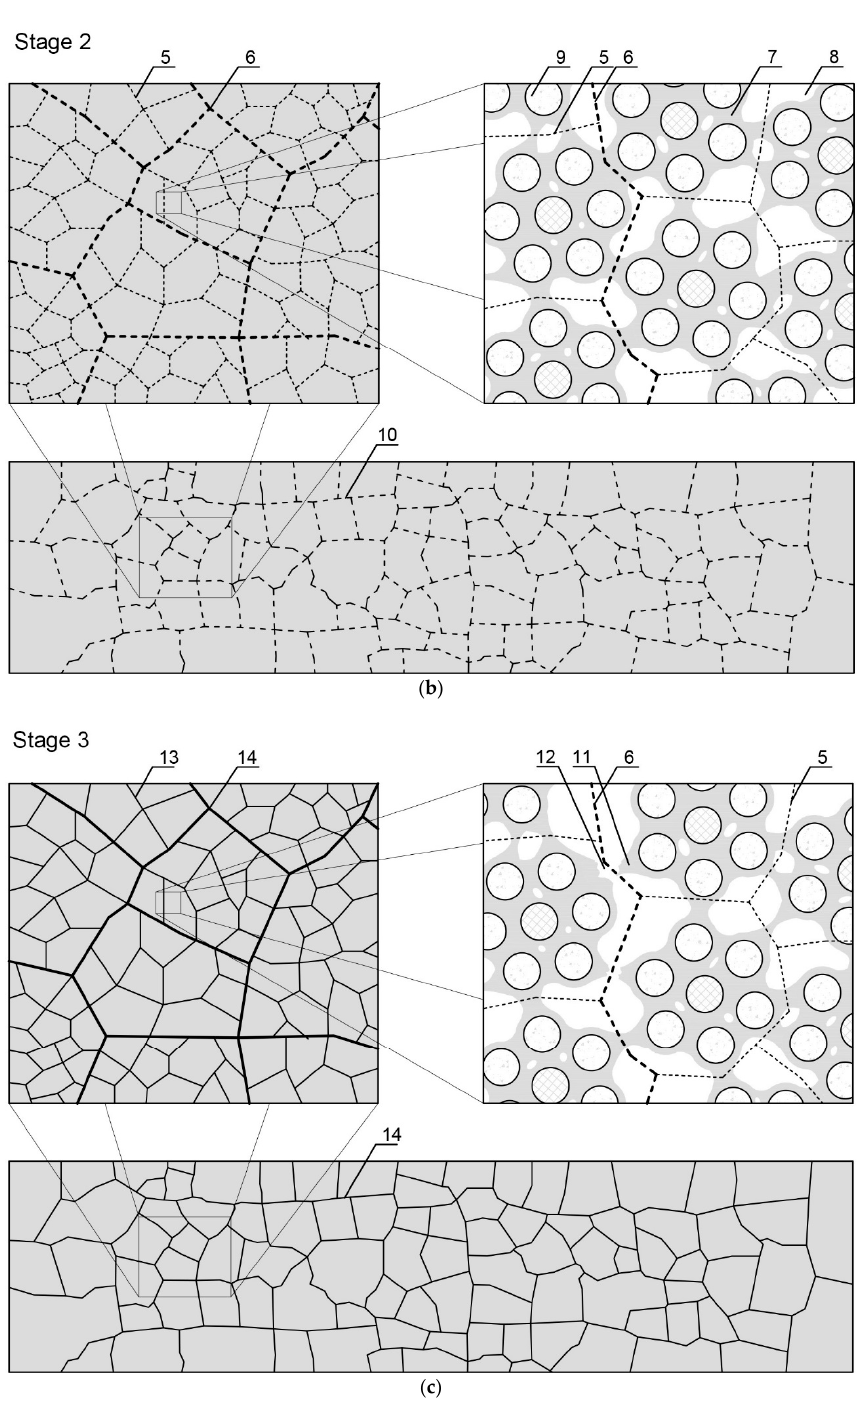
Figure 7. Scheme of the evolution of cluster structures into a cracking pattern as a result of a thermal load: ( a ) stage 1—initial structure organization immediately after cement and water connection; ( b ) stage 2—hydration and formation of a solid structure; and ( c ) stage 3—appearance of stress/strain in the material and formation of a cracking pattern. 1—Surrounding cement particle; 2—forming cement particle; 3—water environment; 4—resultant forces of interaction between cement grains; 5—lower-level separation surface between clusters; 6—higher-level separation surface between clusters; 7—cement hydration products; 8—pores; 9—partially-hydrated cement grain; 10—separation surface between clusters at the highest level of observation; 11—place of contact breaking; 12—crack formation and propagation zone; 13—cracking pattern on a lower level; and 14—cracking pattern on a higher